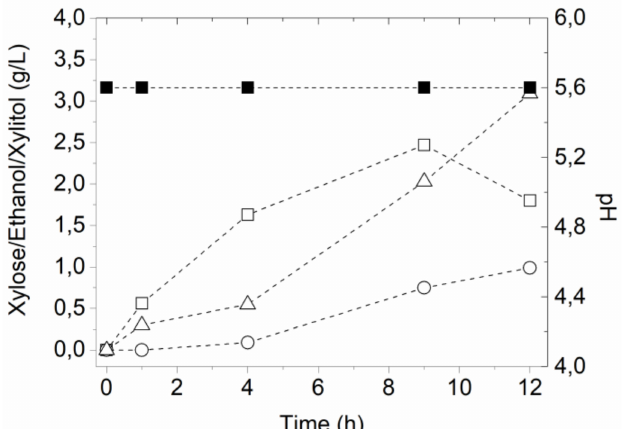
Figure 4. SHIF of previously hydrolyzed birchwood xylan with pH control and excess of Mg 2+ using immobilized biocatalyst containing 5 w % Multifect xylanase derivative, 15 w % XI derivative, and 10 w % yeast (1.7 x 10 4 IU/L, 3.7 x 10 4 IU/L, 50 g/L), initial pH 5.6, 150 rpm stirring and 32 ◦ C; pH ( (cid:4) ), xylose ( (cid:3) ), ethanol ( ∆ ), and xylitol ( (cid:35)